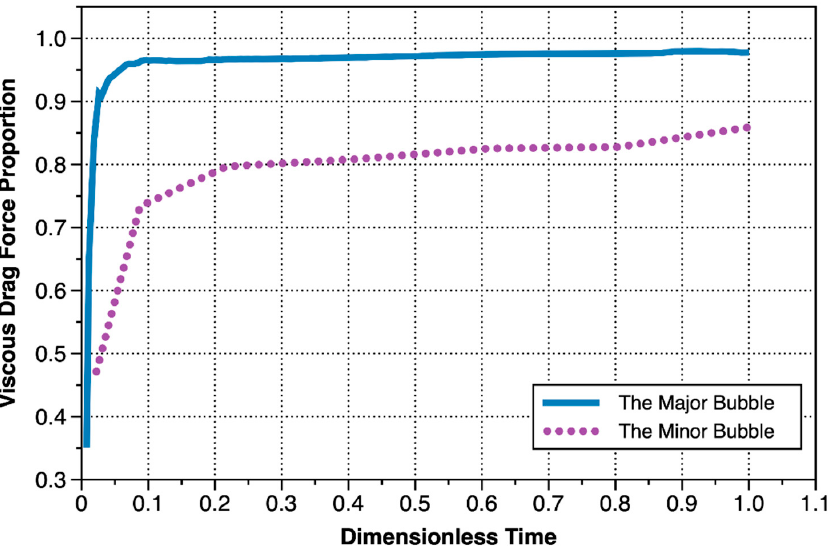
Figure 14. Proportion of viscous drag force at bubble growth stage.